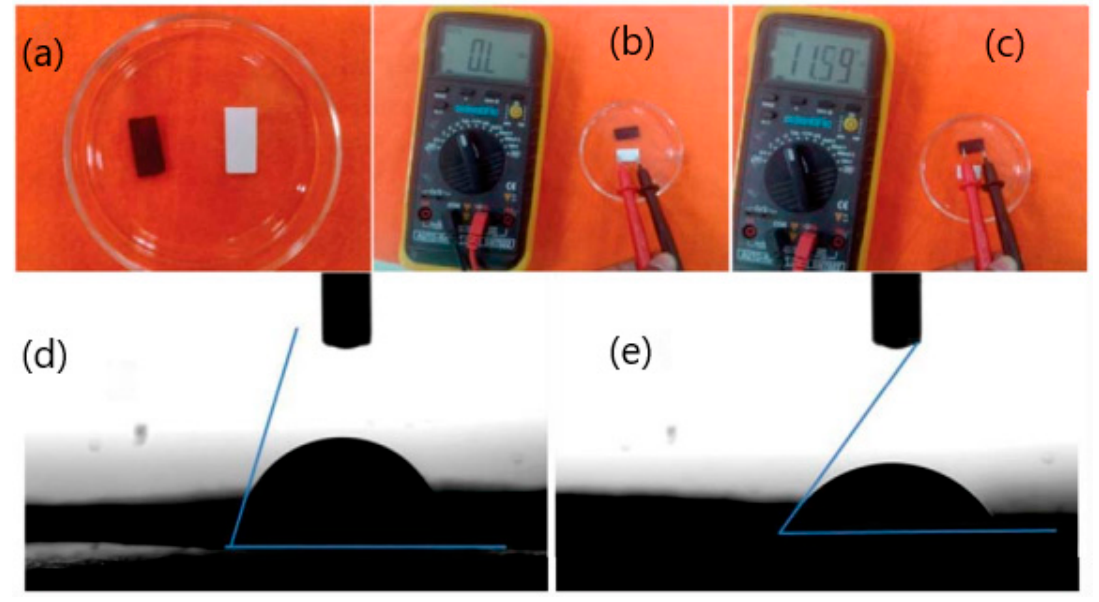
Figure 7. Photos of paper (white) and conducting paper strips (black) (a,b,c); contact angle measurement of conducting paper strips (d); (3-aminopropyl) triethoxysilane (APTES) functionalized conducting paper strips (e) [36] .